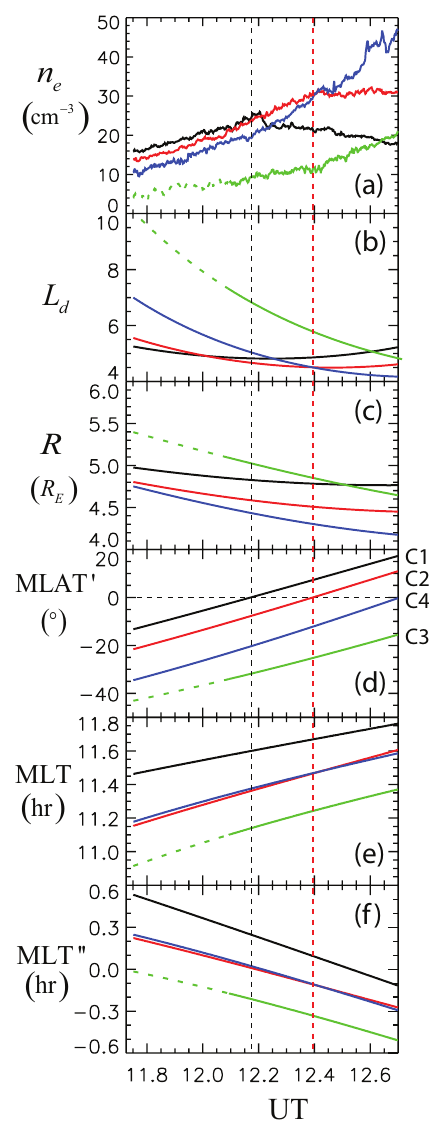
Fig. 8. Quantities for each of the four CLUSTER spacecraft (black, red, green, and blue for C1, C2, C3, and C4, respectively) plotted as a function of UT, (a) n e values inferred from the upper hybrid noise band, (b) L d calculated using the dipole field model (Eq. 9) with the modified magnetic latitude MLAT 0 (Eq. 11), (c) the geocentric radius R , (d) MLAT 0 , (e) magnetic local time MLT, and (f) the co- rotation local time MLT 00 (Eq.